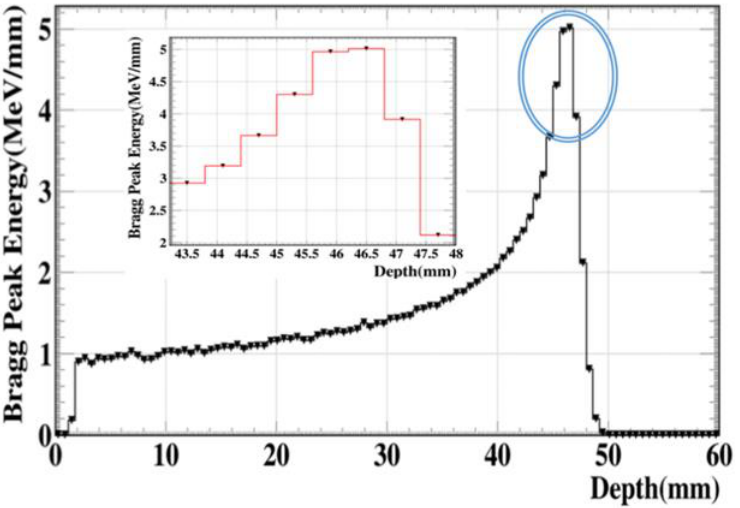
Figure 2. Physical energy deposition profile in Bragg peak region for mono-energetic 100 MeV proton beam at 60 mm depth.